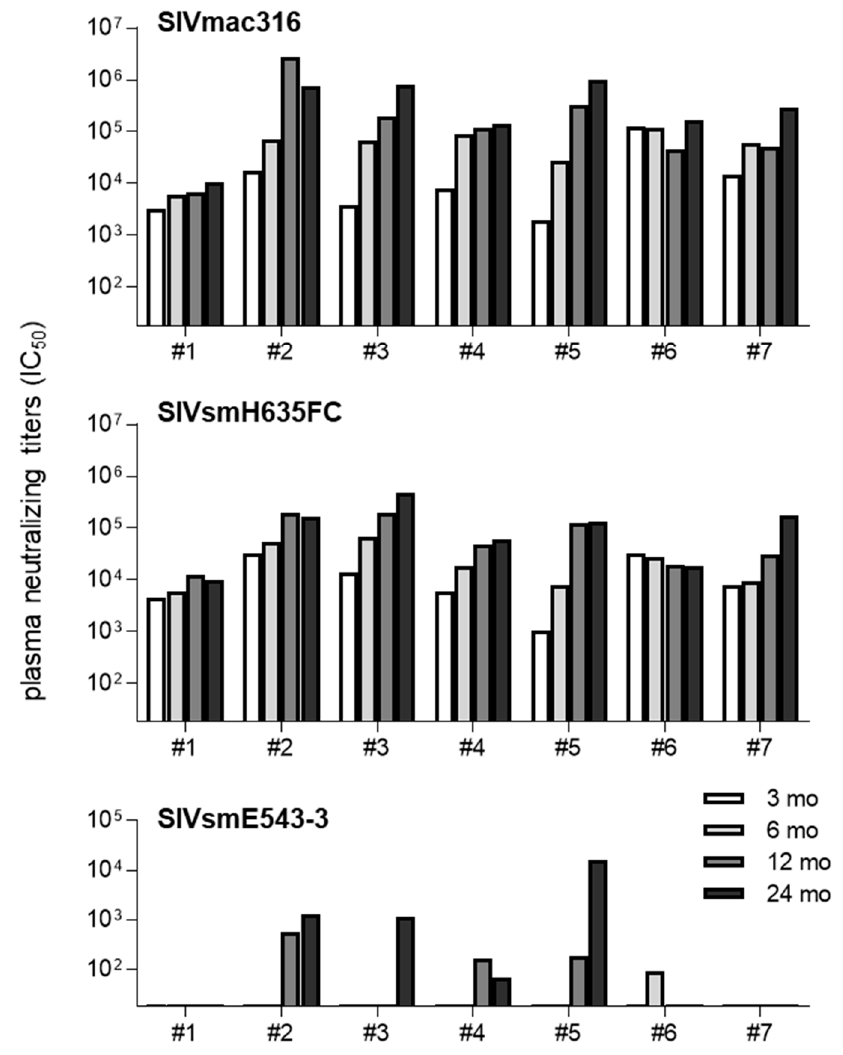
Figure 2. Plasma NAb responses in rhesus macaques after SIVsmE543-3 infection. Plasma neutral- izing titers (plasma dilution of half maximal inhibitory concentration (IC 50 )) against SIVmac316 (top), SIVsmH635FC (middle), and SIVsmE543-3 (bottom) at month 3, 6, 12, and 24 post-infection are shown.